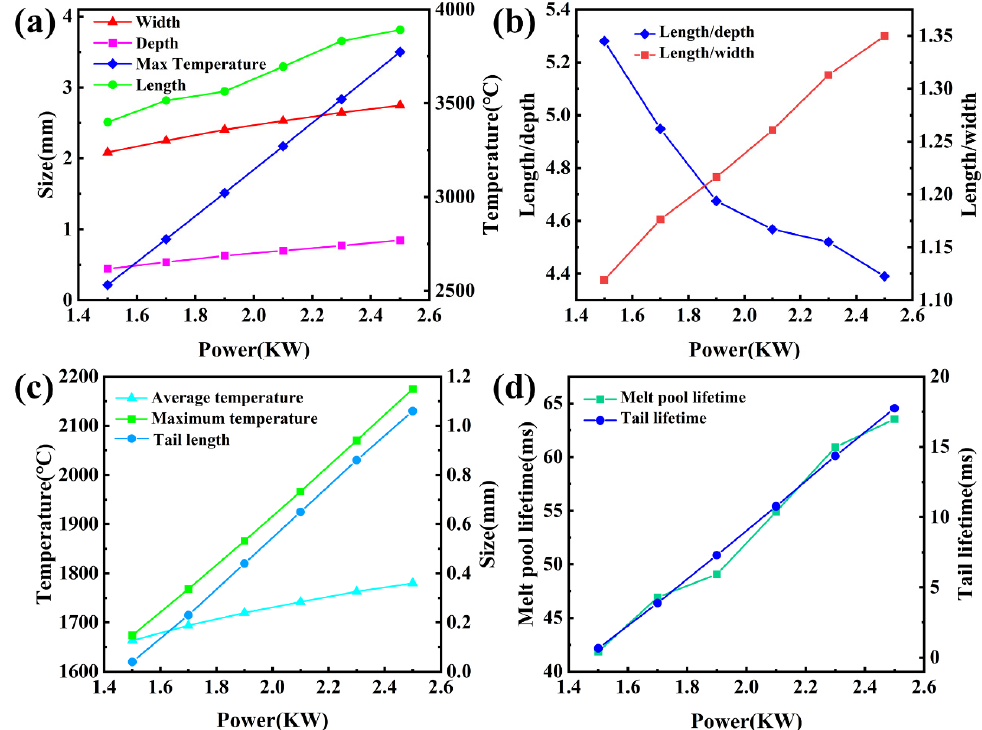
Figure 3. When the laser power varies in the range of 1.5–2.5 kW, ( a ) molten pool morphology; ( b ) characteristics of the molten pool; ( c ) tail morphology; ( d ) molten pool